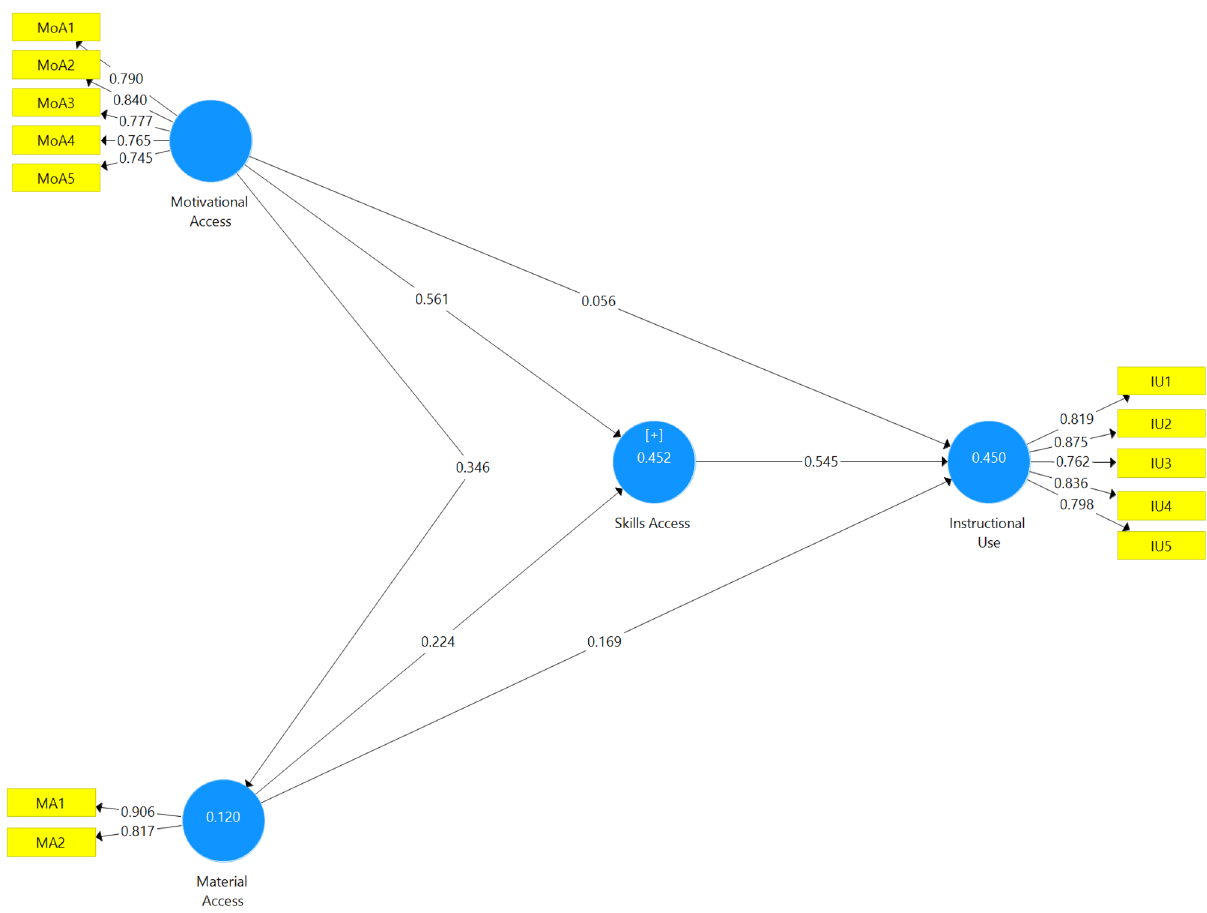
Figure 2. Measurement